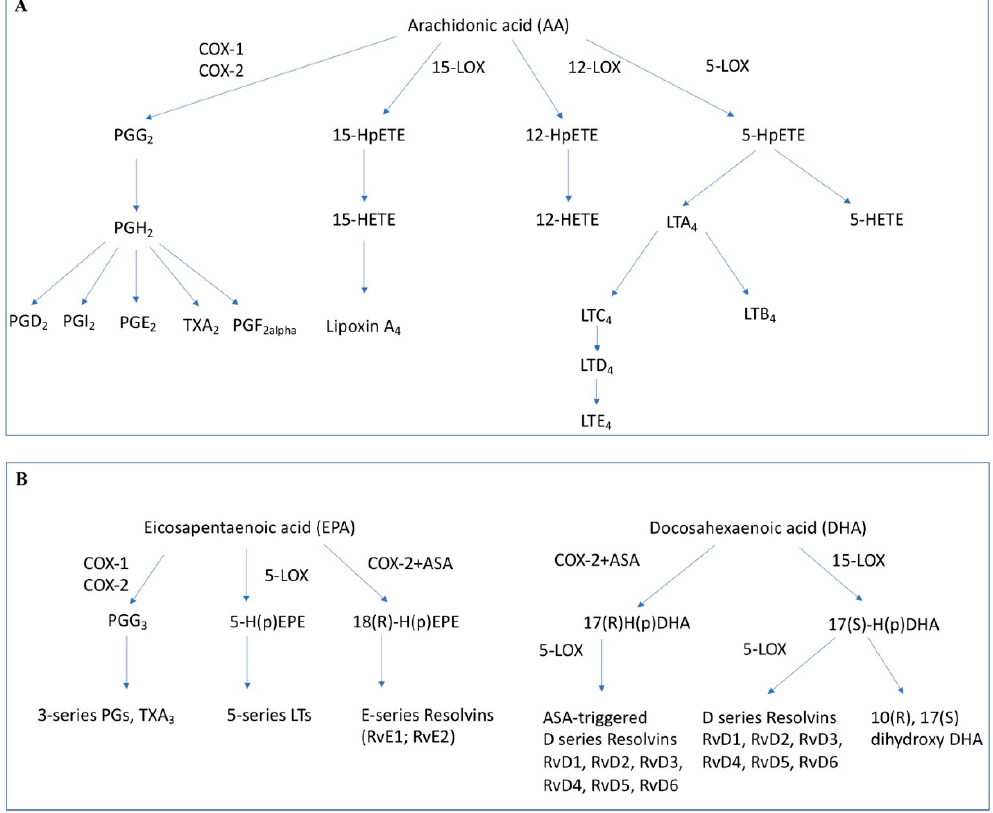
Figure 1. Lipid mediators formed from arachidonic acid ( A ) or eicosapentaenoic acid